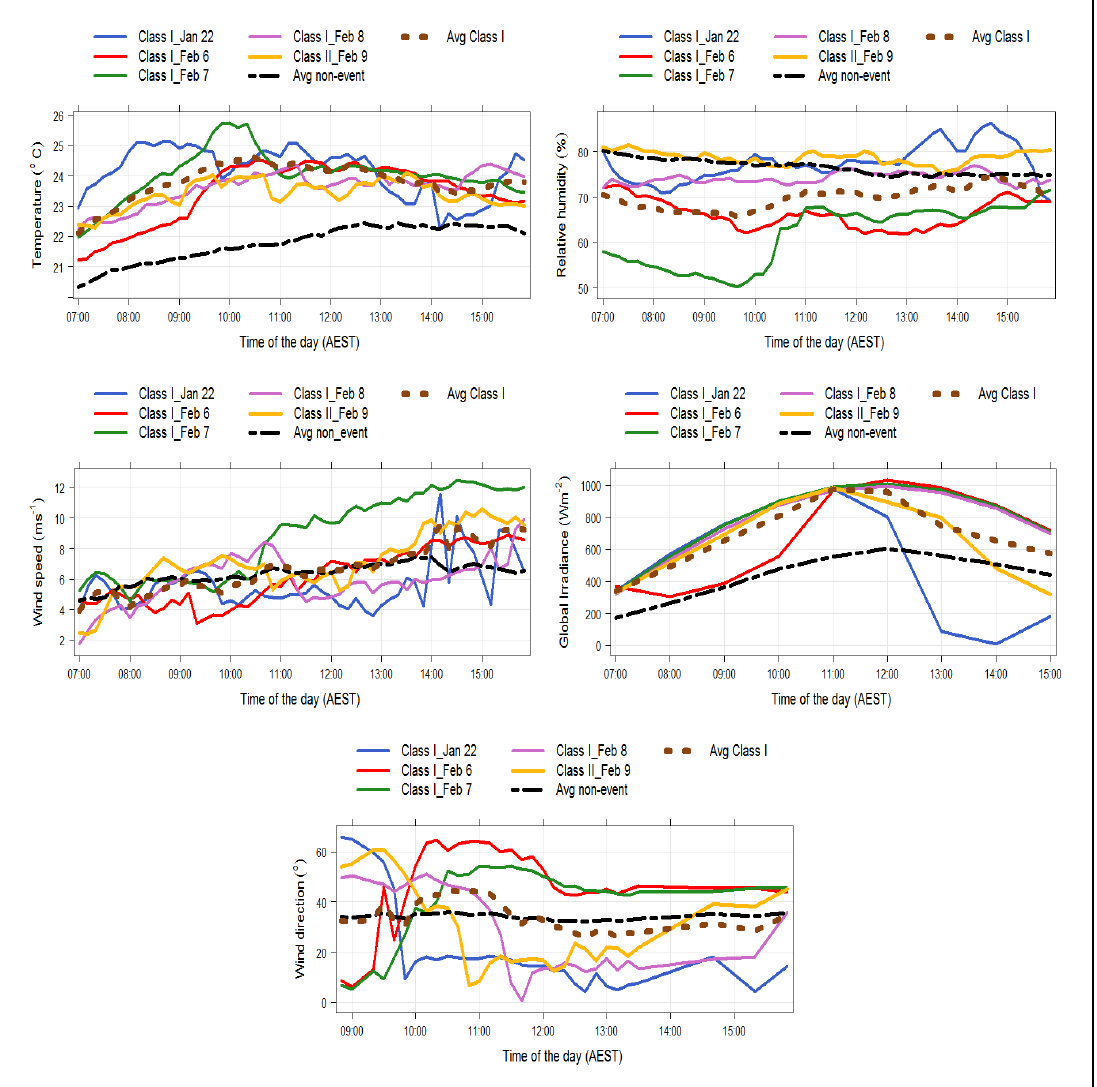
Figure 5. Time series of temperature, relative humidity, wind speed, wind direction and global irradiance on Class I event days (22 January, 6 February, 7 February and 8 February 2013), a selected Class II event day (9 February 2013). Average value of meteorological variables on non-event days and Class I event days are also included. Ten-minute averaged data were used in these plots except for global irradiation, which was averaged hourly. Only measurements from 7:00–15:00 AEST are